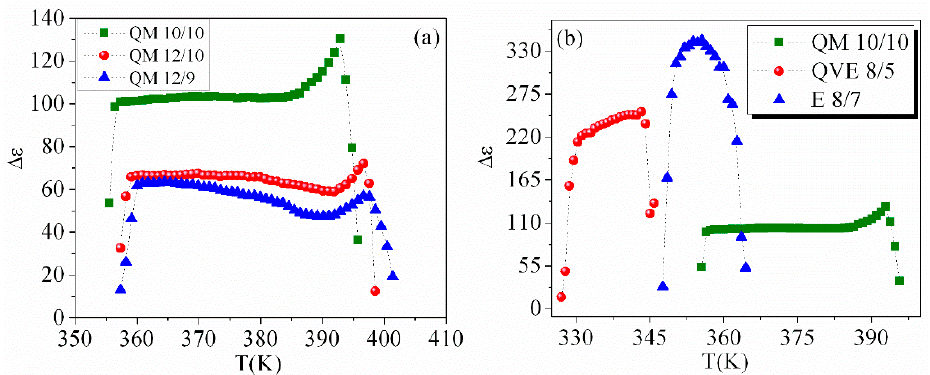
Figure 4. Temperature dependence of the dielectric strength ( ∆ε ) within the temperature range of the SmC* phase for: ( a ) structurally similar QMn/m compounds differing only in the length of the terminal alkyl chains; ( b ) structurally different QVE8/5 , E8/7 and QM10/10 compounds. The temperature dependence of relaxation time and relaxation frequency for QMn/m series is shown in Figure 5a.